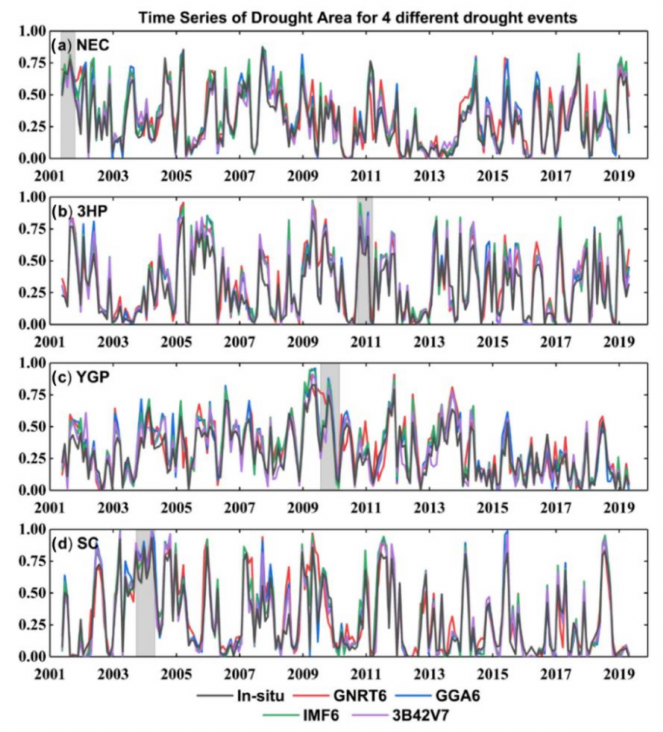
Figure 10. Time series of ratio of drought area of the four typical drought-affected areas (( a ) NEC, ( b ) 3HP, ( c ) YGP and ( d ) SC) during 2001–2019. Gray backgrounds indicate the period of the typical drought